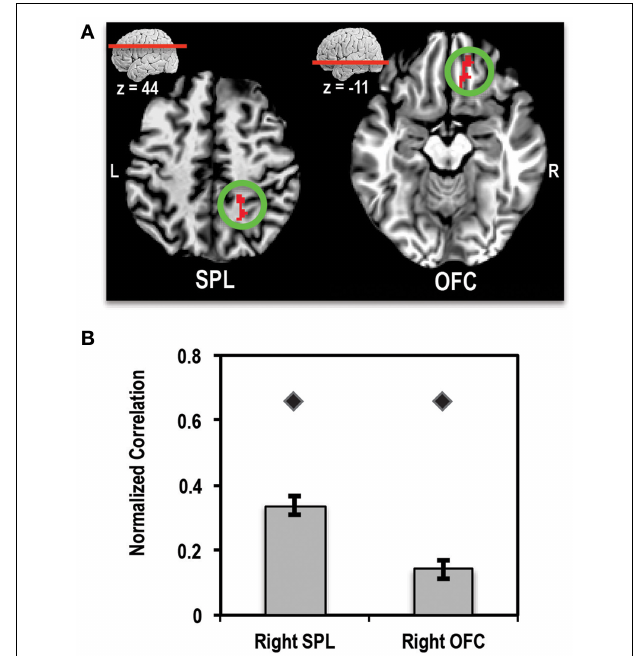
FIGURE 7 | (A) Axial slices showing the location of clusters in right superior parietal lobule (SPL) and right orbitofrontal cortex (OFC) where the patient showed significantly higher connectivity ( > 4-SD beyond mean of control group) with left MFG seed than controls. L, Left; R, Right. (B) Bar plot showing the mean normalized correlation values in right SPL and right OFC regions of interest (ROIs) in controls (bars) and the patient (diamond markers). Error bars represent standard error of the mean of correlation values for the control